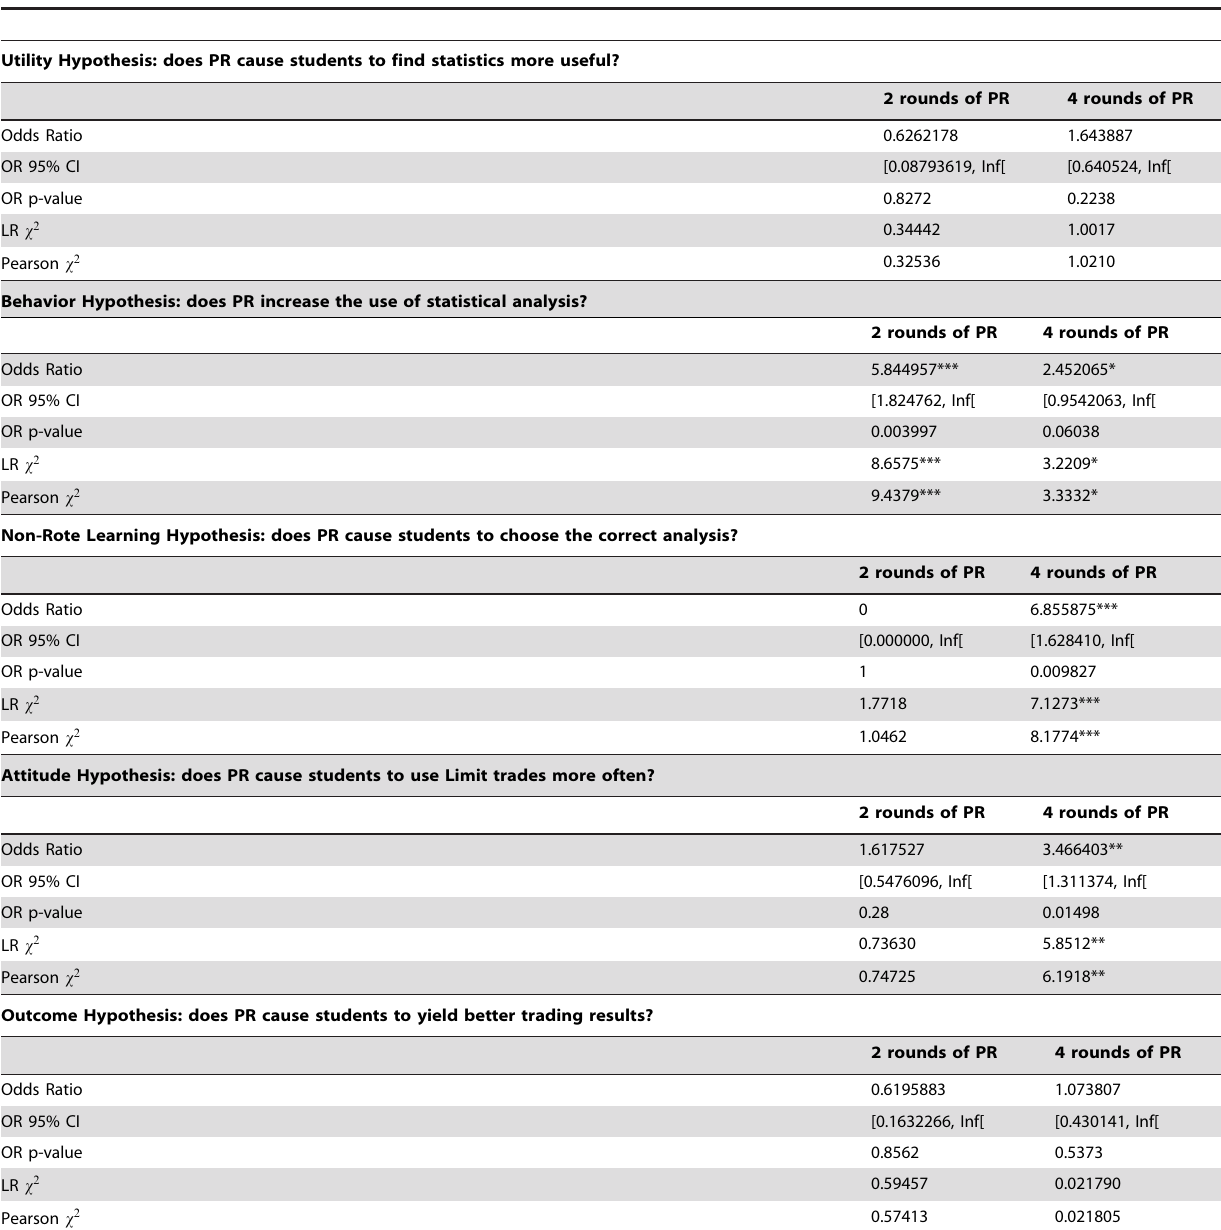
Table 2. Fisher’s Exact Test for Count Data (www.wessa.net/rwasp_PRexperiment.wasp).